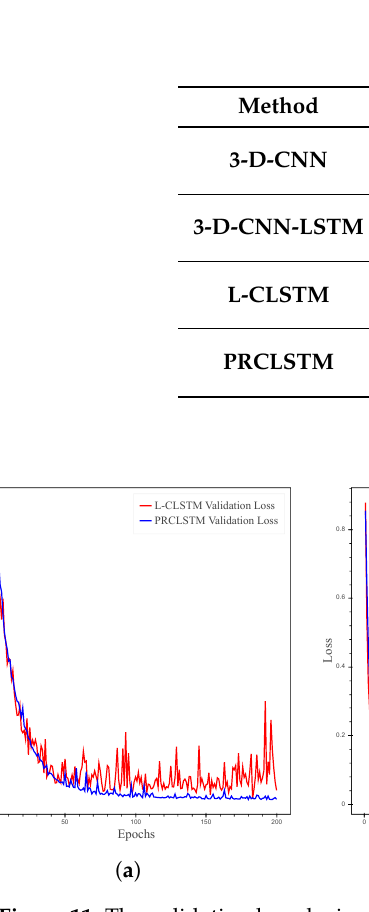
Figure 11. The validation loss during the training of the L-CLSTM and PRCLSTM for ( a ) Indiana, ( b ) PaviaU, and ( c )